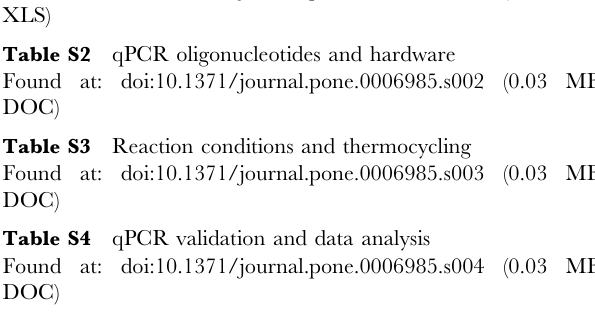
Table S2 qPCR oligonucleotides and hardware